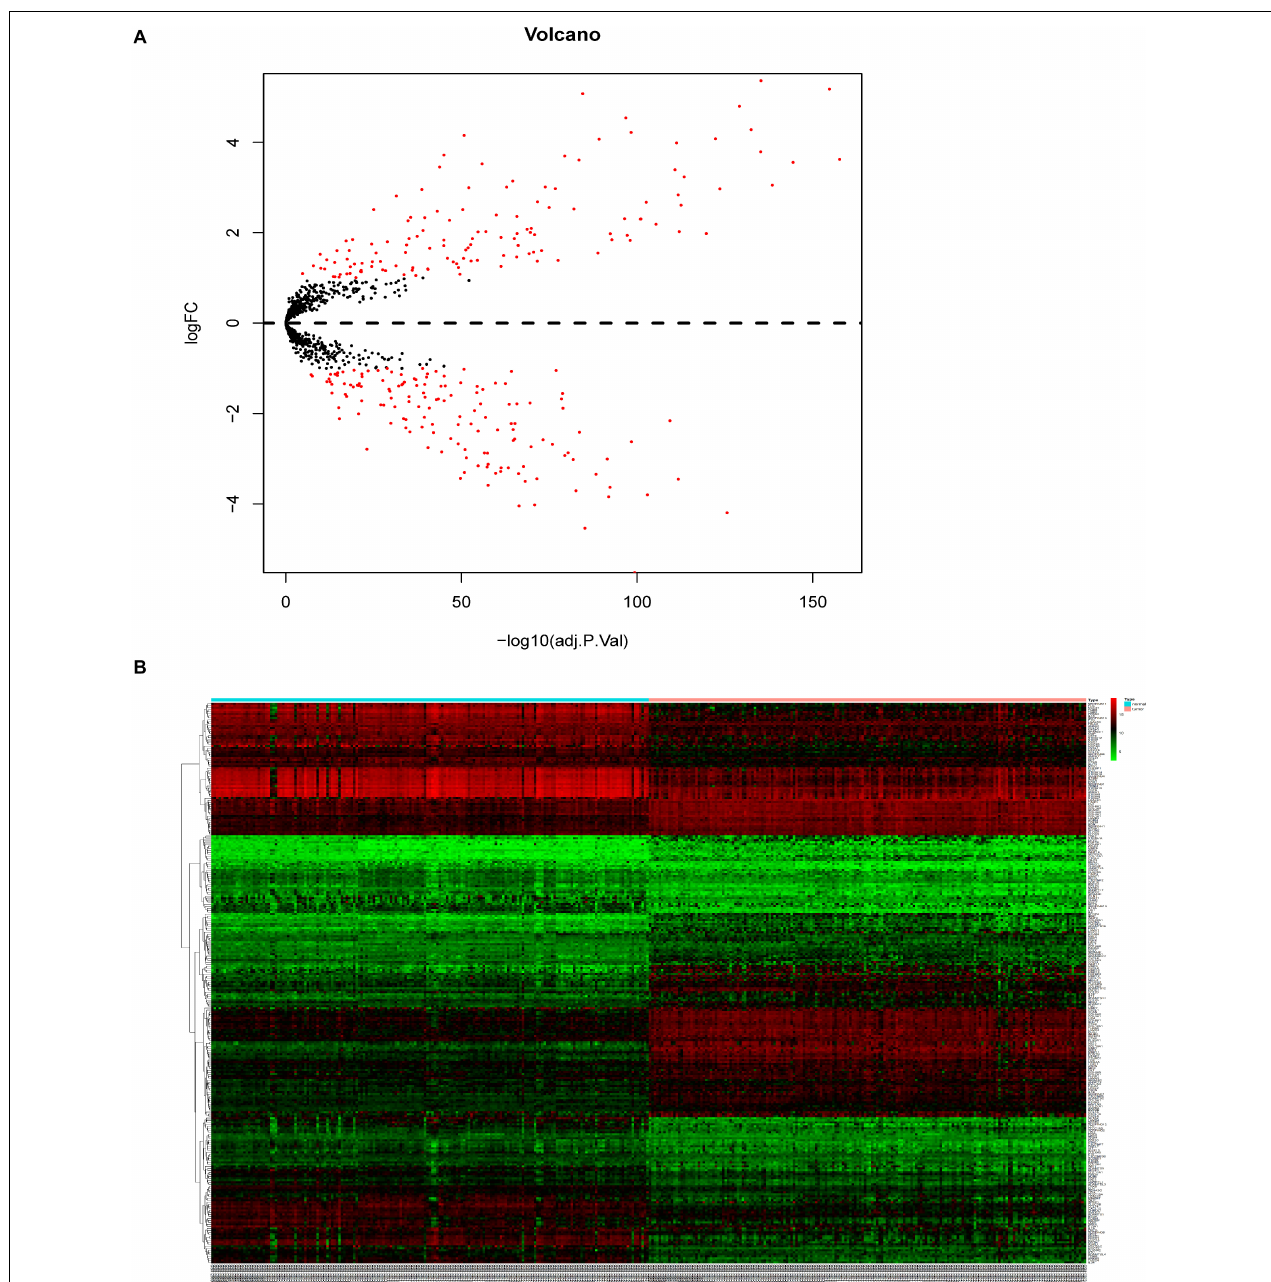
FIGURE 1 | Identification of DEGs in patients with ESCC. (A) Volcano plot of identified DEGs. (B)